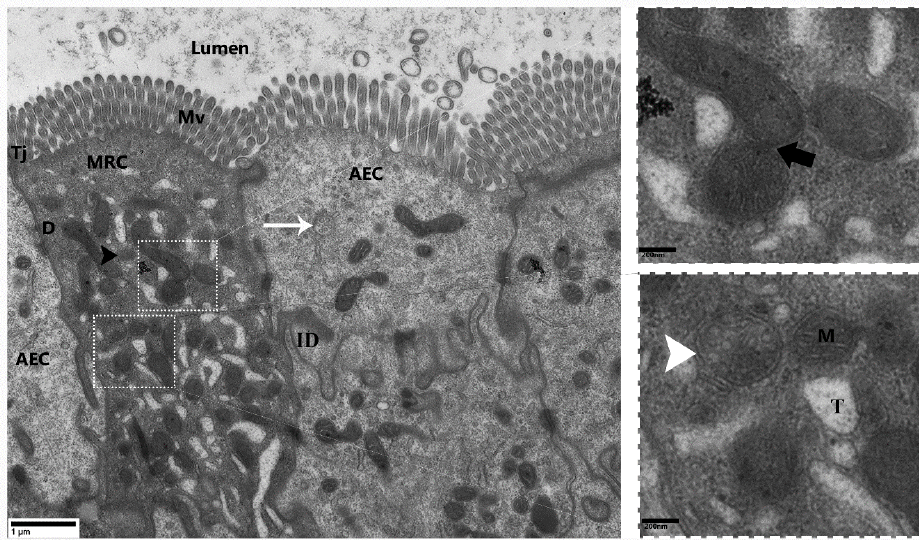
Figure 3. Transmission electron micrograph of an MRC that exhibits exosome secretion in the mucosal layer of P. sinensis . Mitochondria-rich cells (MRCs), absorptive epithelial cell (AEC), mitochondria (M), tubular system (T), multivesicular bodies (white arrow), exosome (exo), lysosome (black arrowhead), and microvilli (Mv). Scale bar =1 µm.